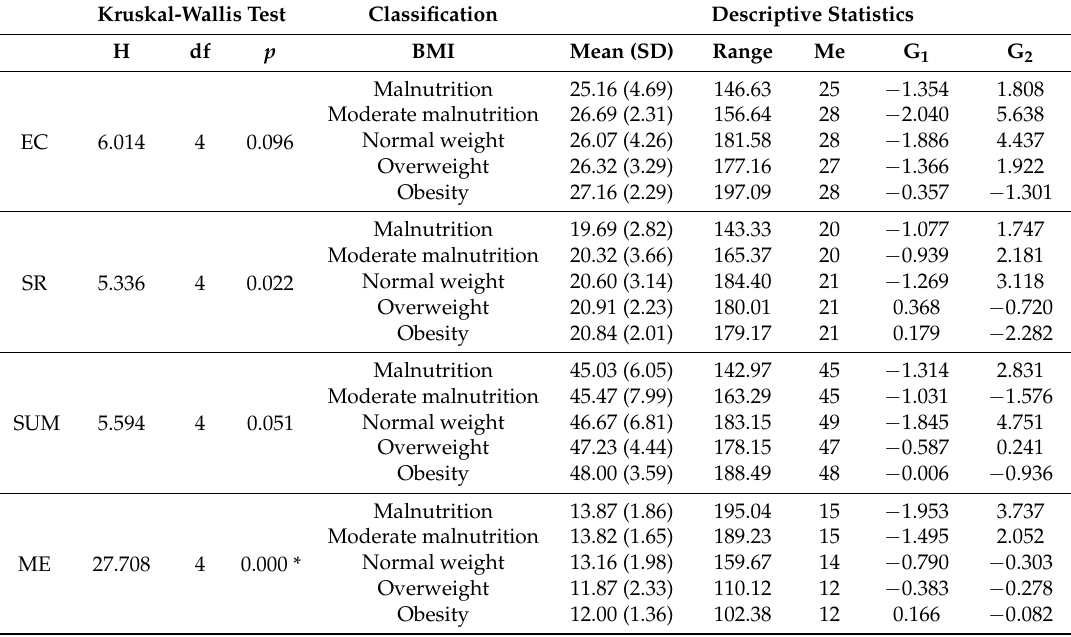
* Asterisks indicate significant differences between some groups. EC = emotional control, SR = social relationships, SUM = total score on the physical-motor factor, H = Kruskal-Wallis H test. SD = standard deviation, Me = median, G 1 = skewness, and G 2 =